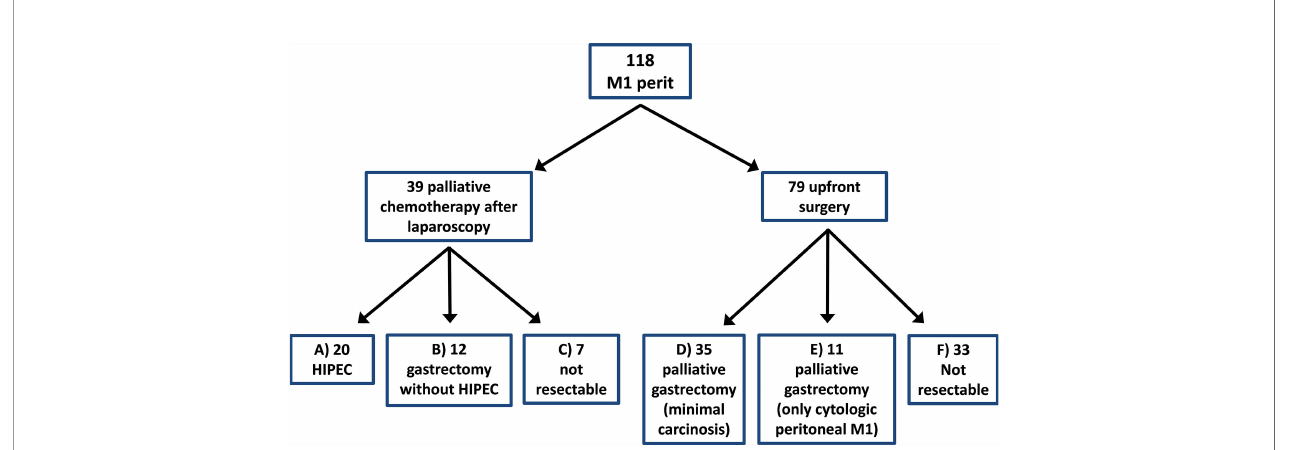
FIGURE 1 | Flow-chart shows the types of